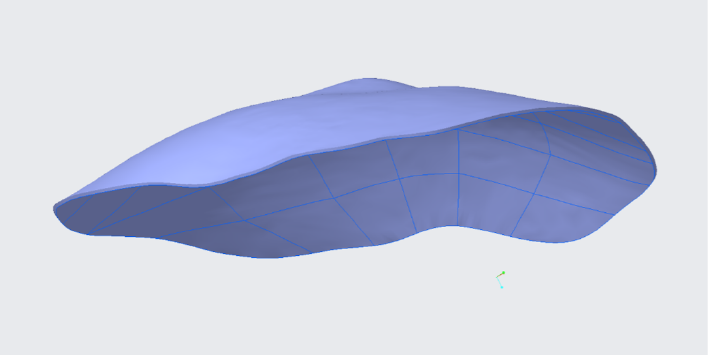
Figure 14. Design of the personalized ostomy